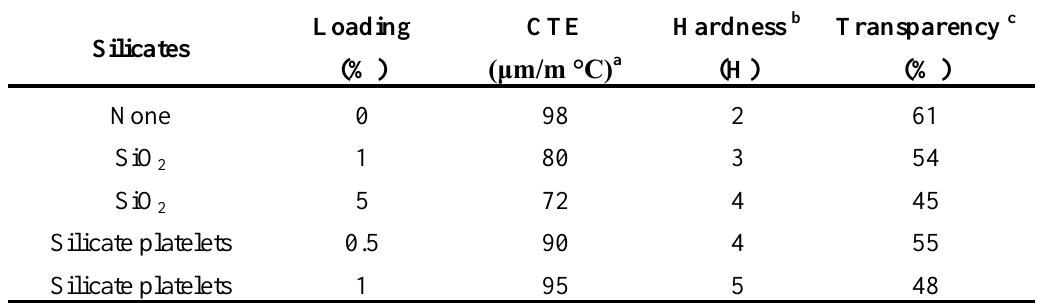
Table 3. Properties of amine-cured epoxy with silica oxides and silicate platelets (reprinted with permission from reference